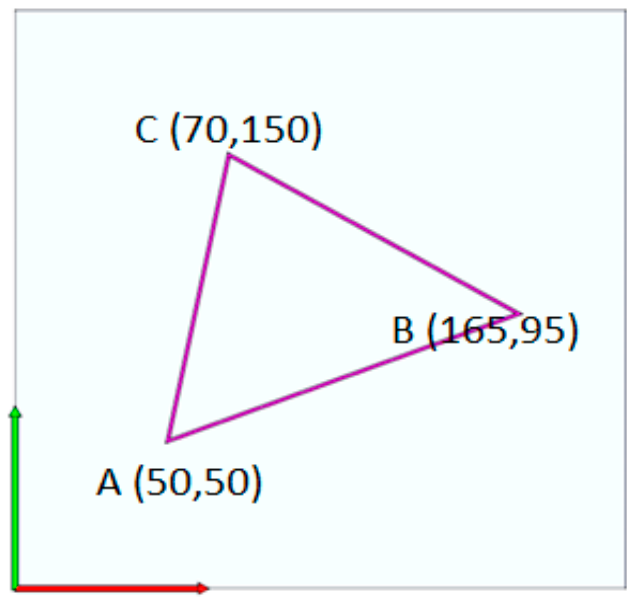
Figure 3. Triangular path created to calculate the filament feed. Table 1. Point coordinates, path length, and calculation of filament feed for each path.